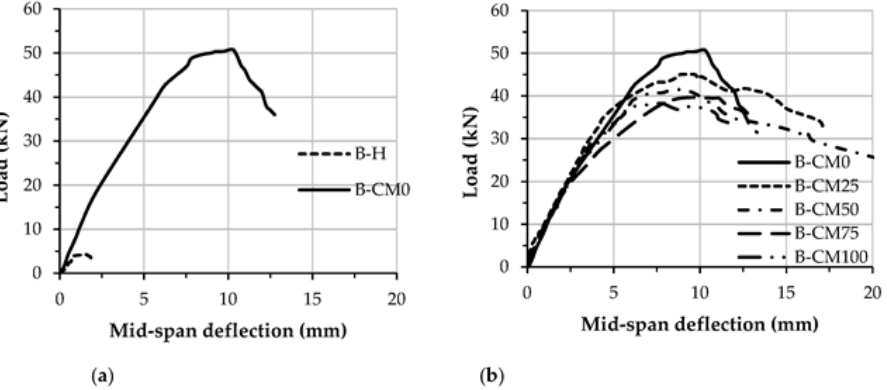
Figure 10. Load vs. mid-span deflection relationship of concrete-filled C-section specimens; ( a ) Hollow and filled specimens; ( b ) Varied contains of recycled aggregates.